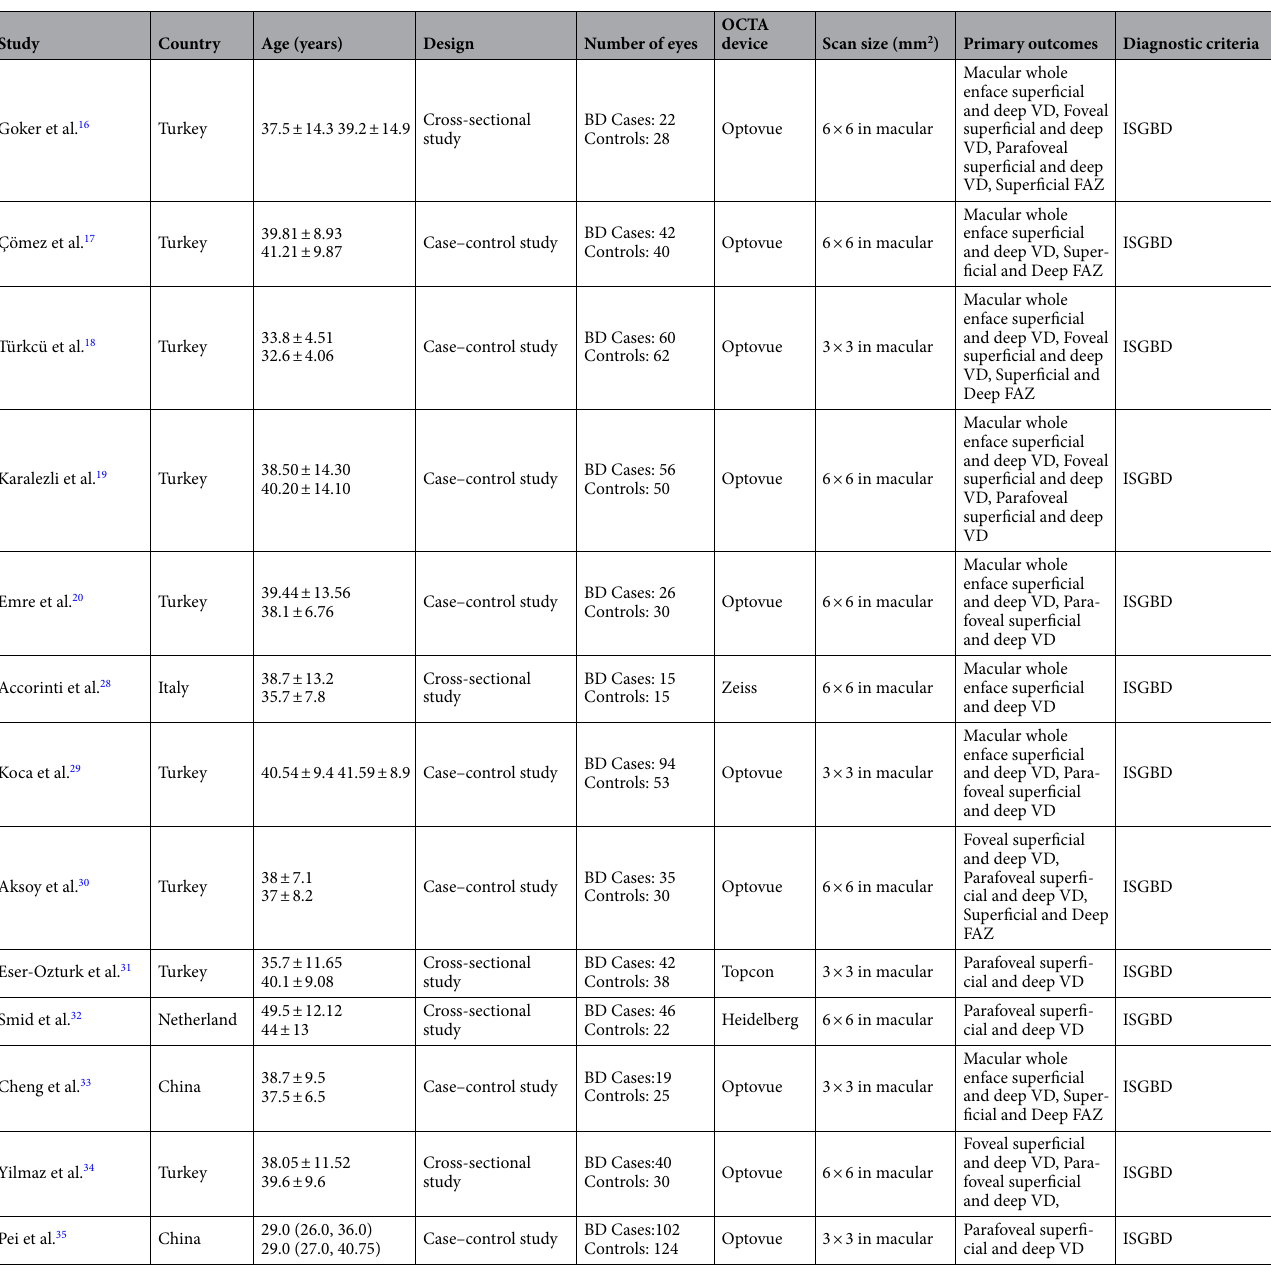
Fig. 5) heterogeneity across studies, respectively. Subgroup analyses in three studies showed that the pooled MD for foveal superficial VD was lower in eyes with ocular BD (MD = − 1.36, 95%CI: − 2.81 to 0.09, P = 0.07; Fig. 6), with mild heterogeneity across studies (chi 2 = 3.82, P = 0.15 I 2 = 48%; Fig. 6). In addition, foveal deep VD was significantly lower in eyes with non-ocular BD (MD: − 2.77, 95%CI: − 4.38 to 1.17, P = 0.0007; Fig. 6), and the related studies showed nearly minimal heterogeneity (chi 2 = 2.02, P = 0.36, I 2 = 1%; Fig. 6). Furthermore, three studies were analyzed for foveal VD in the non-ocular BD and control groups. The dif- ference was significant between the two groups in terms of foveal superficial VD (MD: − 1.68, 95%CI: − 3.26 to